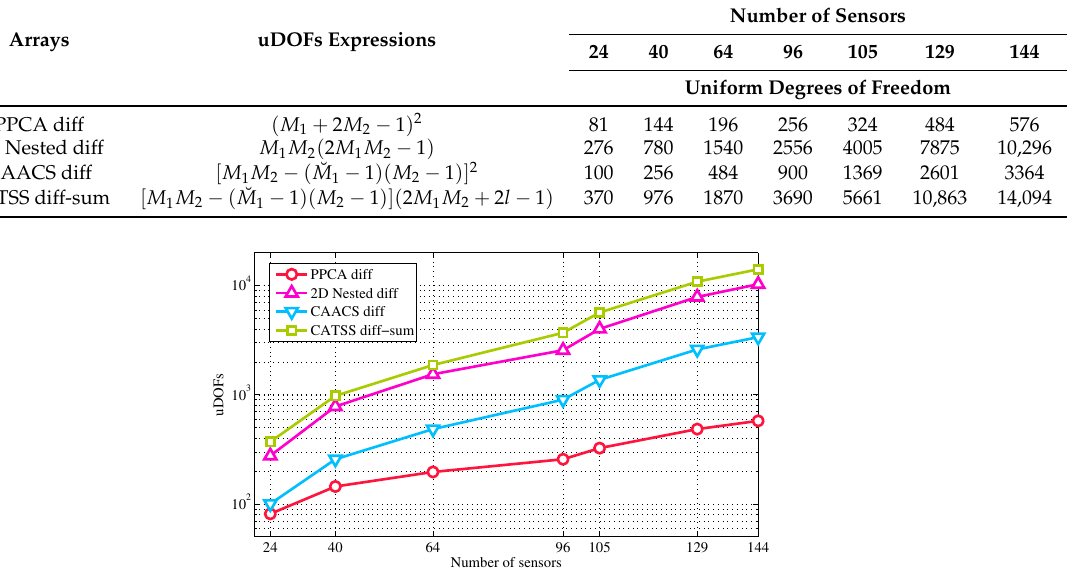
Figure 9. Uniform DOFs (uDOFs) comparison of different array